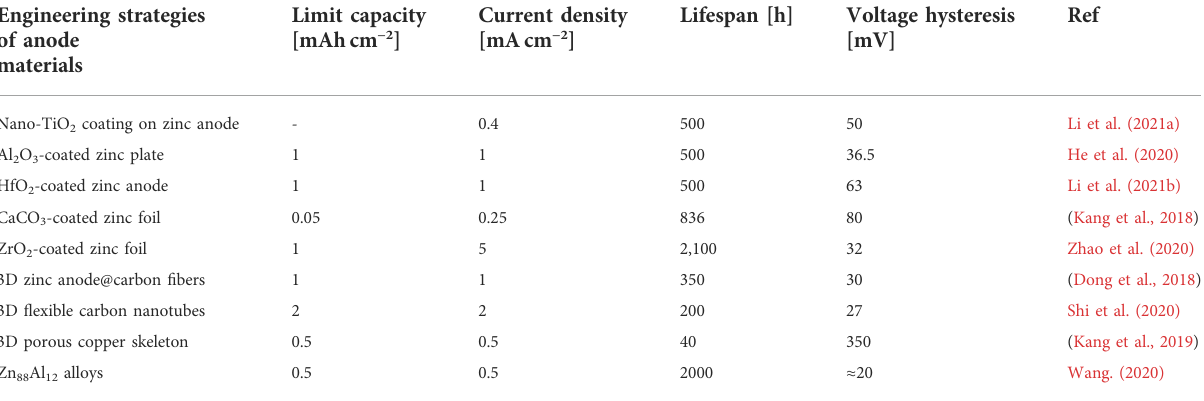
TABLE 1 An overview of recently reported dendrites free engineering strategies of zinc-based anode